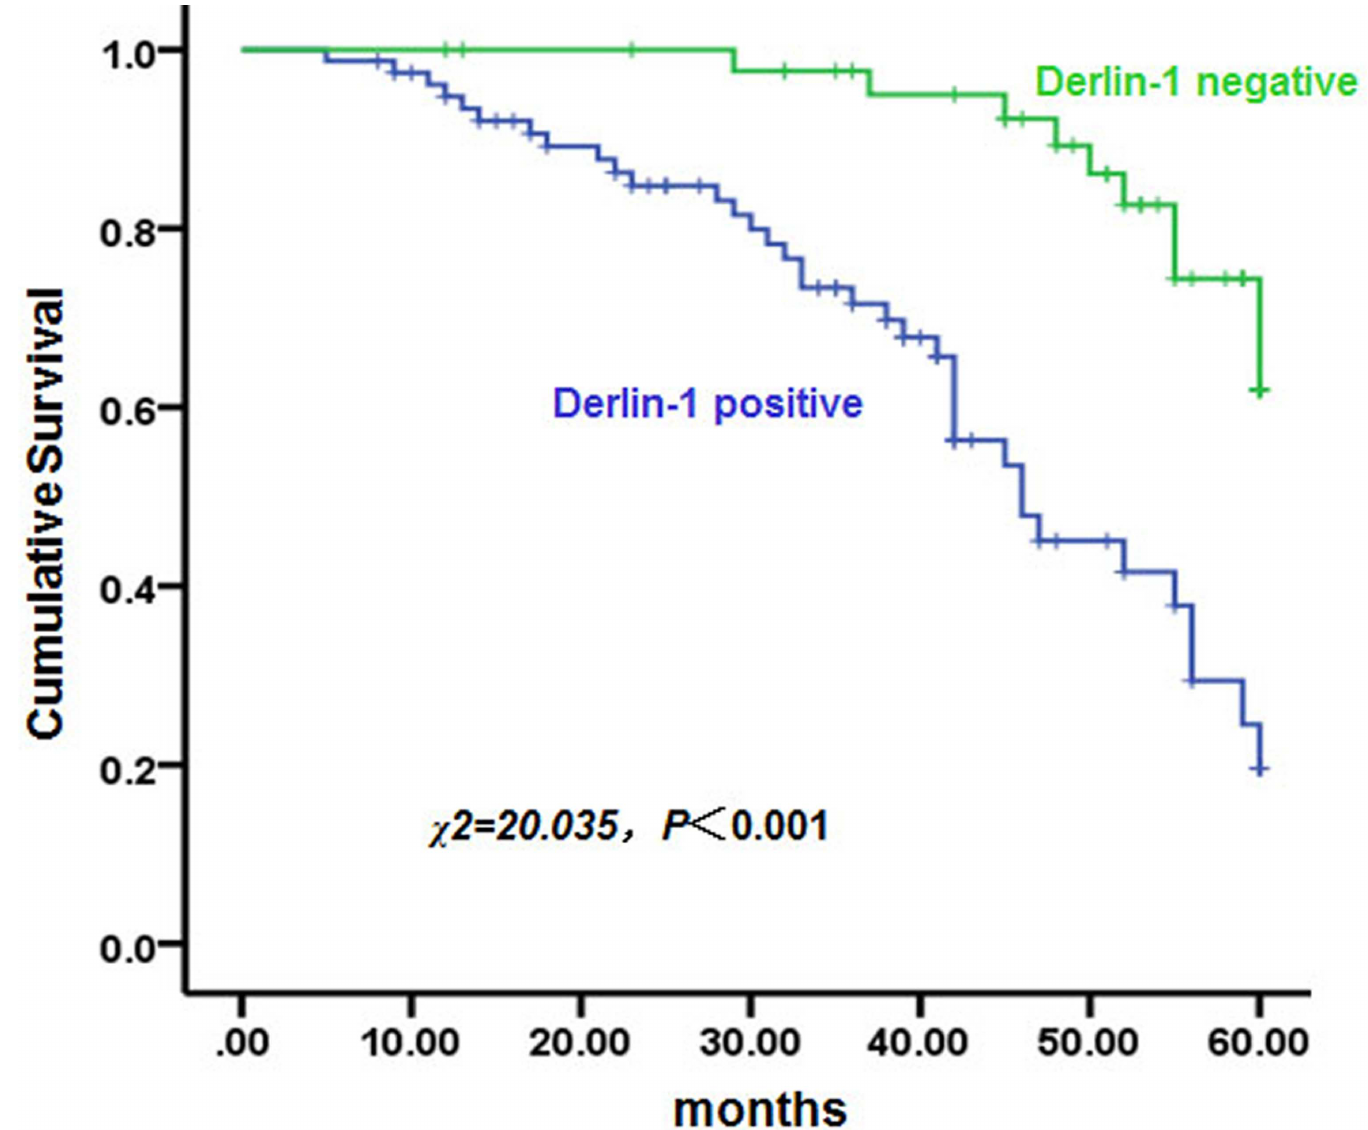
Fig 8. Analysis of 5-yearoverall survival in patients with positive or negative Derlin-1 expression. Kaplan–Meier survival analysiswas used to compare5-year overall survival betweenpatients with positive or negativeDerlin-1expression. P < 0.001, comparedwith patients with negative Derlin-1